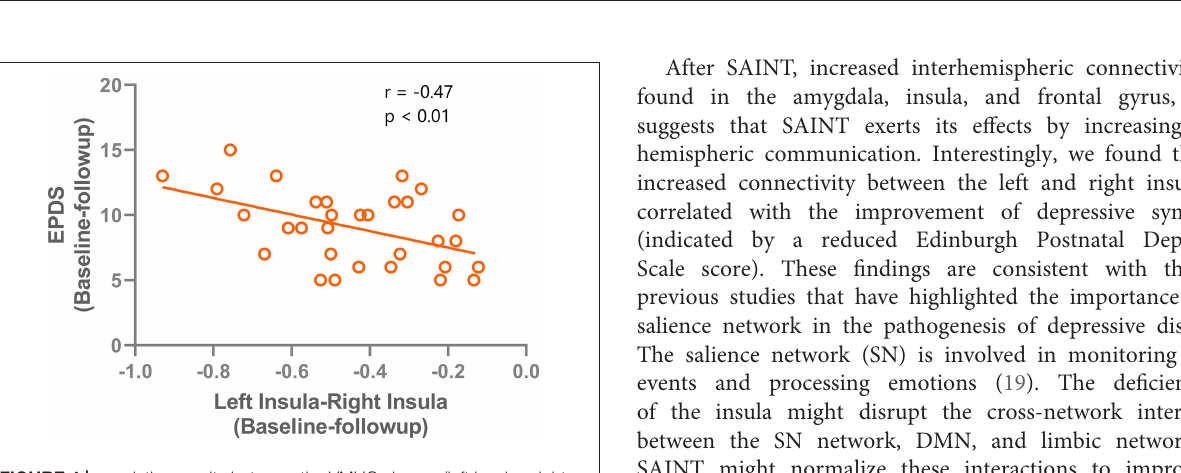
FIGURE 4 | correlation results between the VMHC change (left insula - right insula) and the Edinburgh Postnatal Depression Scale improvements after rTMS